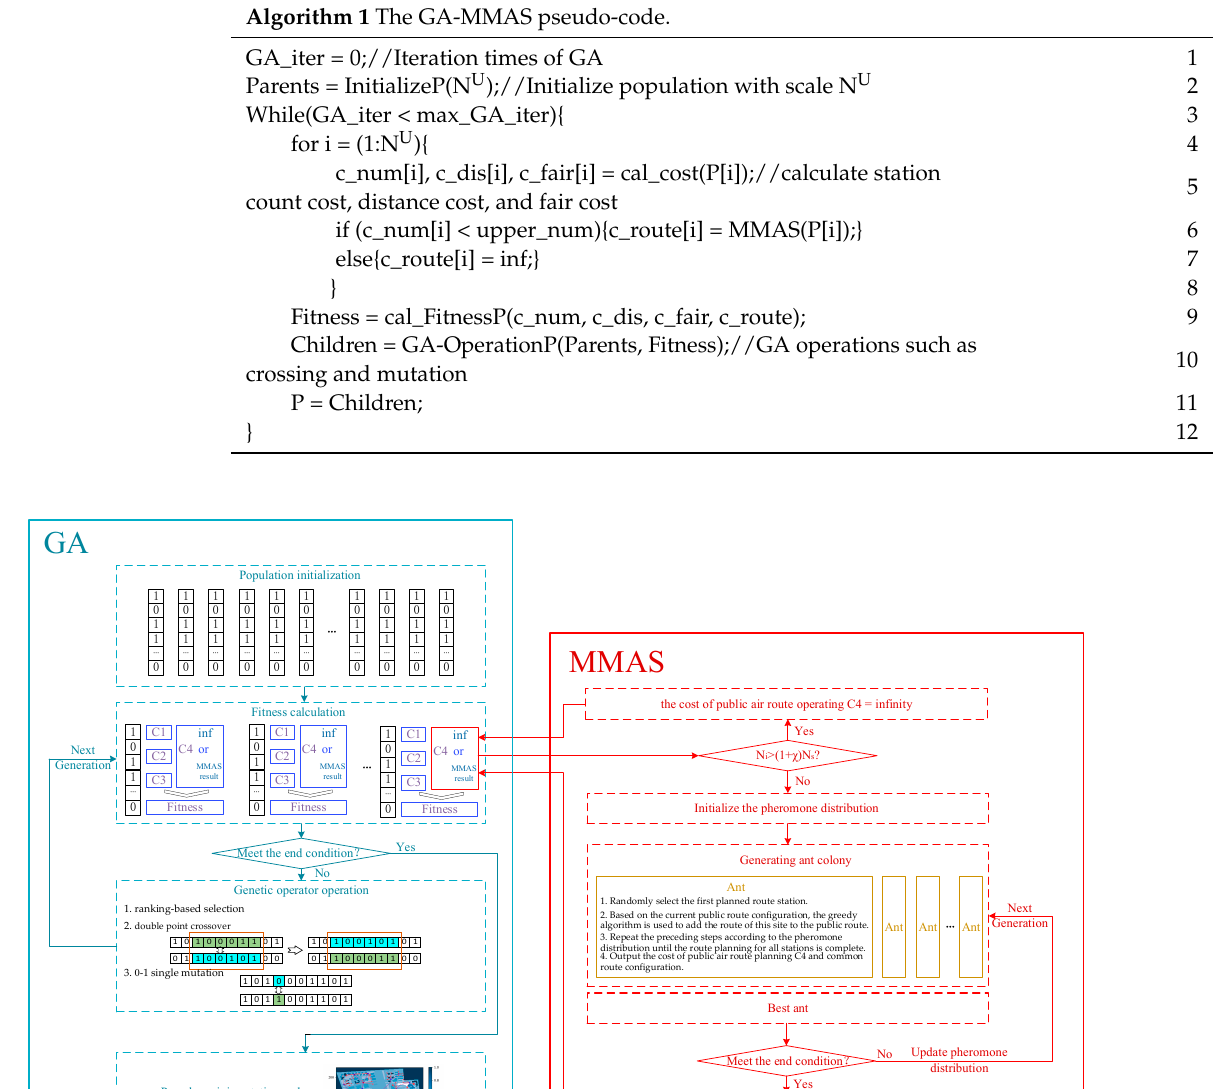
Algorithm 2. The max–min ant system pseudo-code.